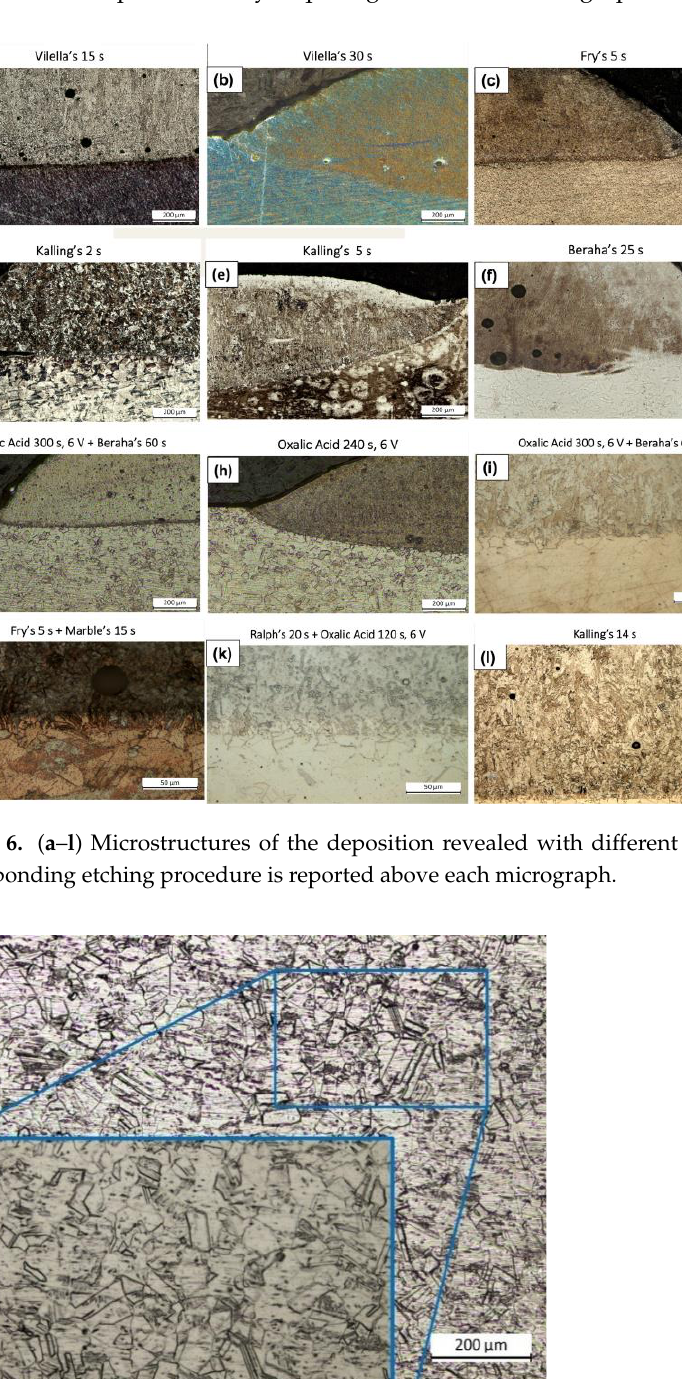
Figure 7. Microstructure of the AISI 316L substrate electrolytically etched in 10% oxalic acid solution for 240 s and 6 V.